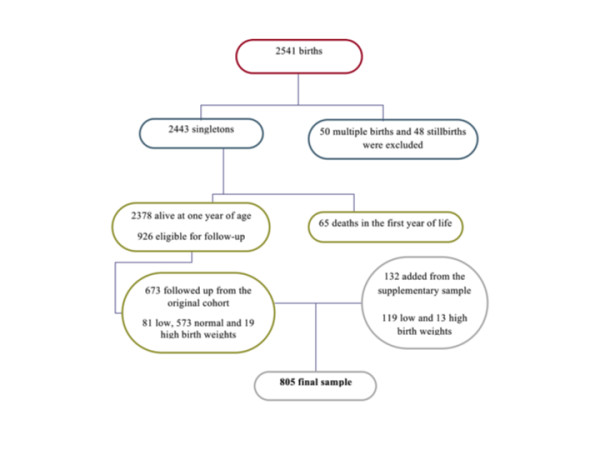
Flow chart diagram of São Luís birth cohort baseline and follow-up.